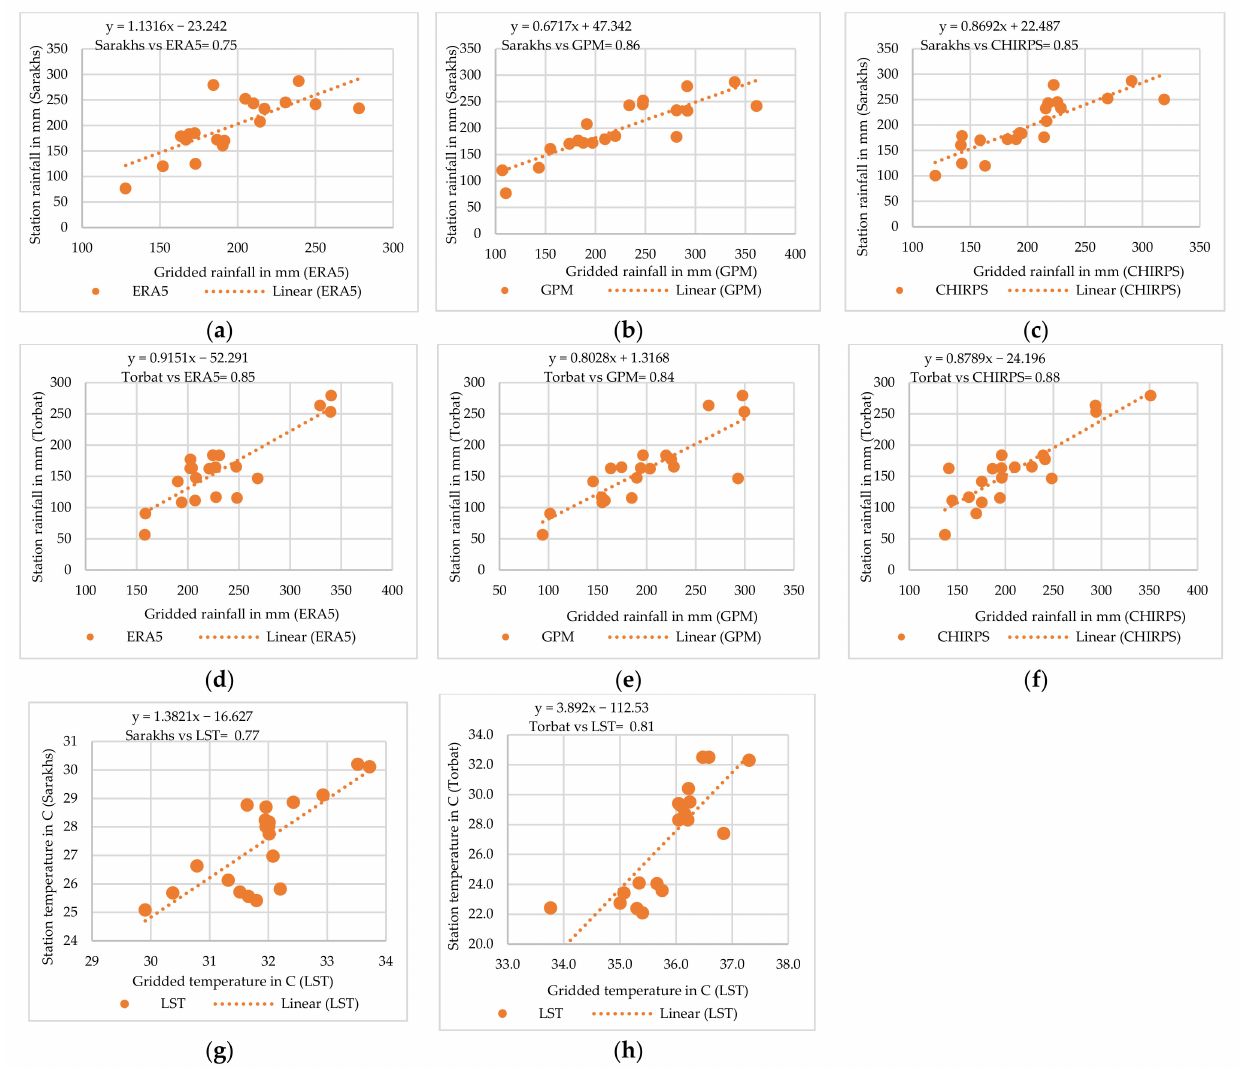
Figure 3. The relationship between gauge datasets and the gridded rainfall ( a – f ) and relationship between gauge datasets and LST ( g , h ) for the period from 2001 to